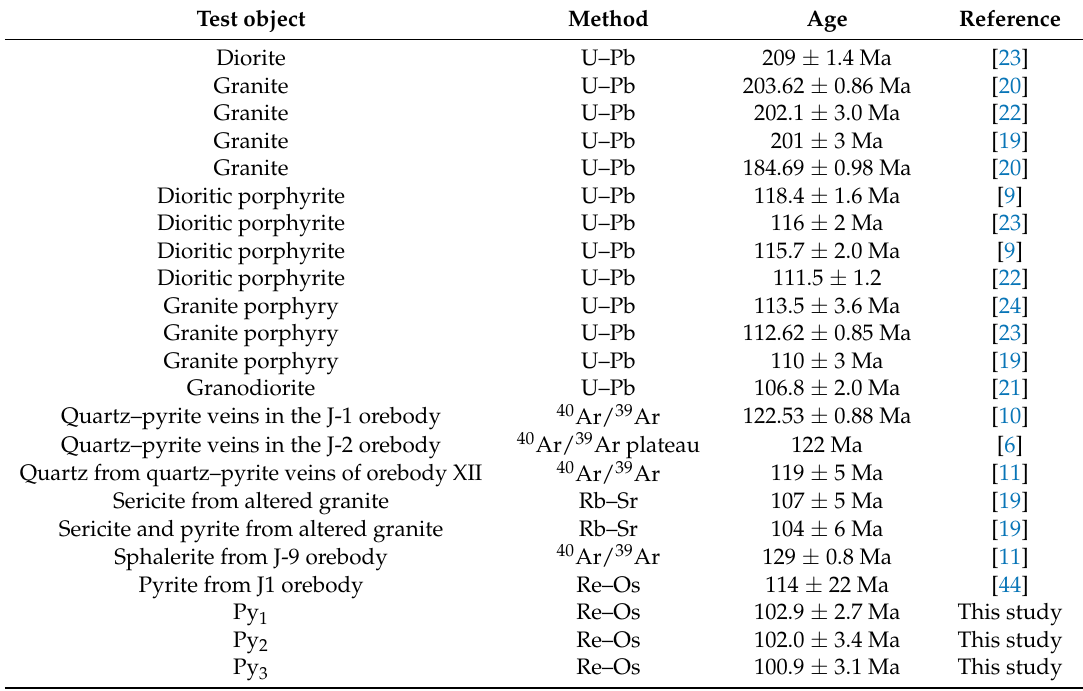
Table 2. Isotopic ages of rocks and minerals from the Jinchang gold